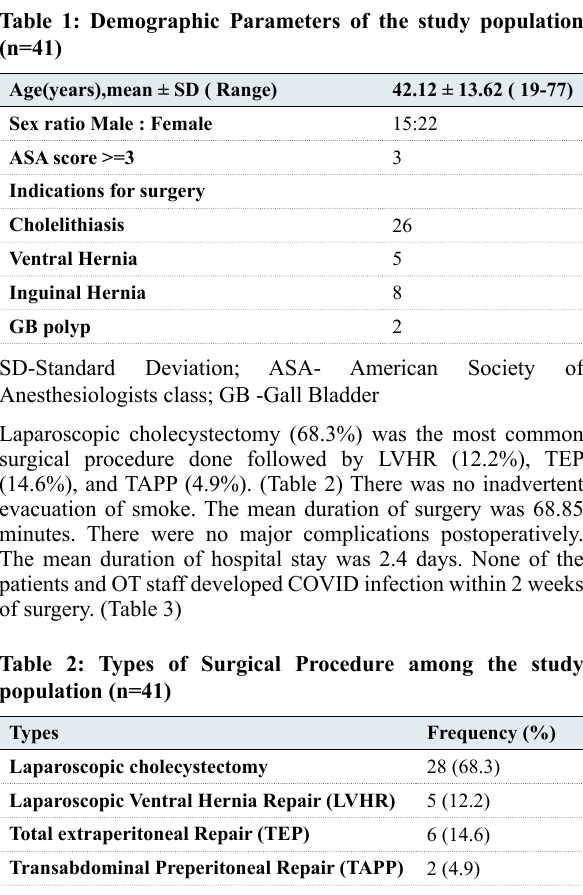
Table 1: Demographic Parameters of the study population